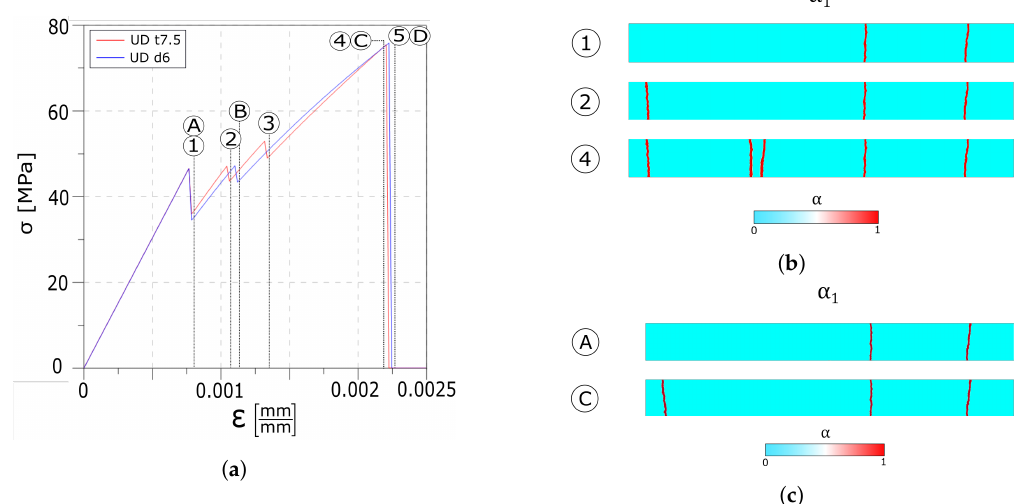
Figure 12. Numerical results: ( a ) Global stress–strain response. ( b ) UD t7.5 crack evolution overview in the first layer. ( c ) UD d6 crack evolution overview in the first layer.